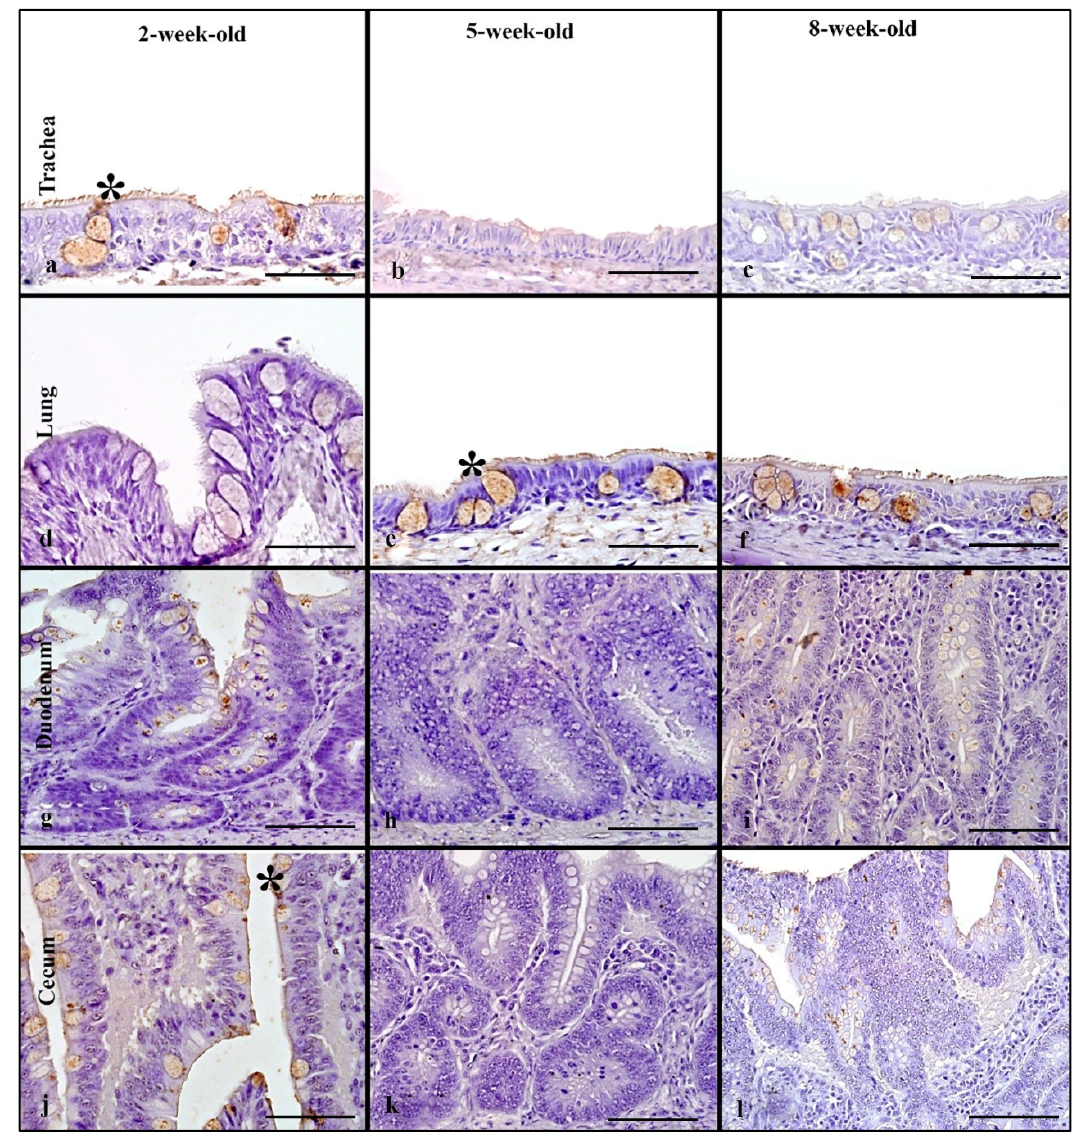
Figure 7. Surface area of LPAIV H5 rHA binding in Muscovy ducks of different age groups, visible as dark brown staining using 3,3-diaminobenzimidine (DAB) HRP via protein histochemistry, denoted by asterisk (*). Note mild levels of binding in the trachea of 5-week-old and 8-week-old Muscovy ducks, compared to moderate binding in the 2-week-old ( b , c ). Moderate levels of rHA binding is also visible in the lung of 5-week-old Muscovy duck ( e ). The level of rHA binding in the intestinal tract is generally mild ( g – l ). Scale bar is 50 µm.